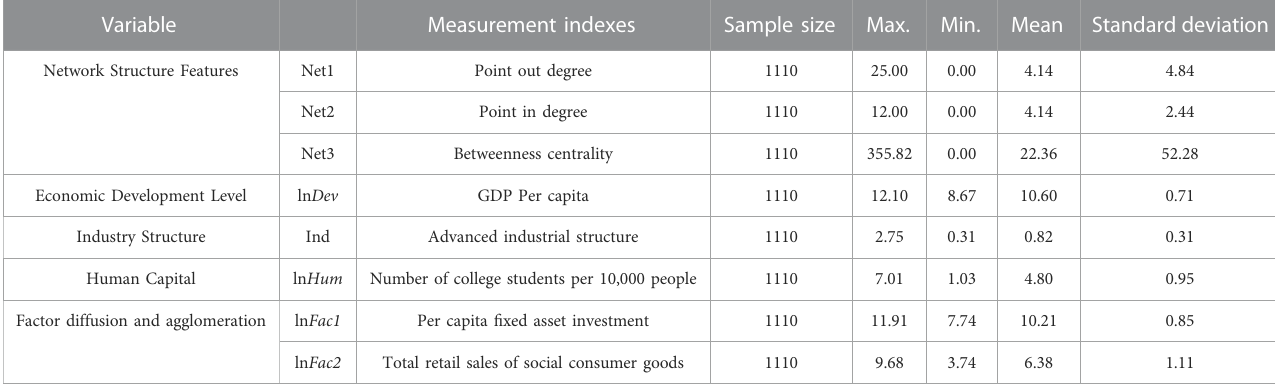
TABLE 3 Descriptive statistics of variables used in regression analysis. Variable